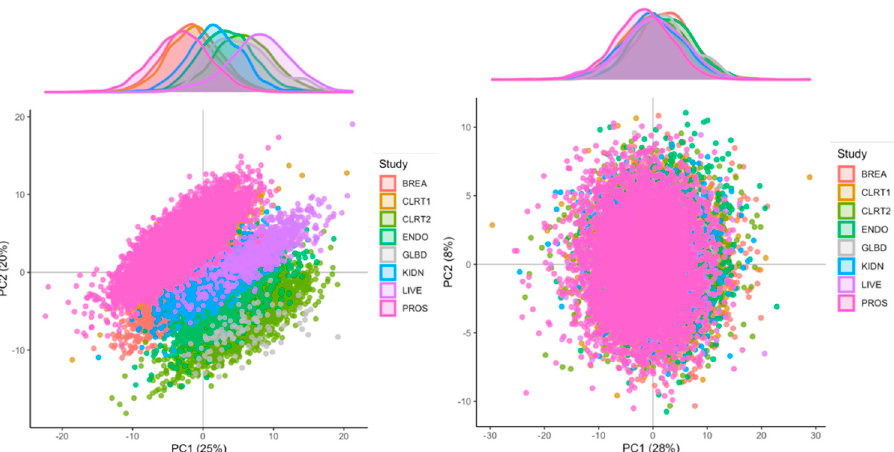
Figure 1. Results from the principal component analysis (PCA); left panel : PCA of the imputed data (i.e., before the normalization step); right panel : PCA of the normalized data. In each plot, the x − axis and y − axis represent the projections of the metabolomics measurements on the first (PC1) and on the second (PC2) principal components, respectively. Proportions of the total variation explained by each component are given in parenthesis in the axis labels.